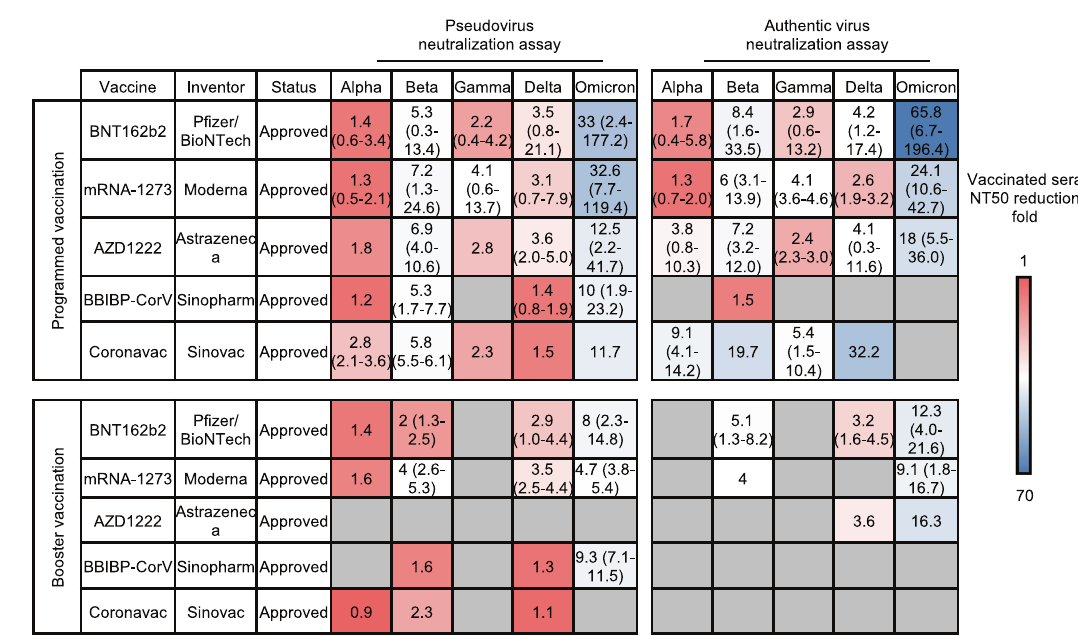
Fig. 7 The summary of reduction folds of neutralization titers of elicited antibody by approved vaccines against in vitro pseudovirus and authentic virus infection from SARS-CoV-2 variants. The average and ranges of reduction folds of neutralization titers against each VOC compared to ancestral strain are listed. The average folds are indicated in a red-to-blue color scale to represent the average neutralizing capability of each vaccine against variants. A bluer color indicates a stronger evasion of VOCs from neutralization of vaccine-elicited antibodies in comparison to the ancestral strain. The detailed neutralization titer reduction from each study could be referred in Supplementary Table